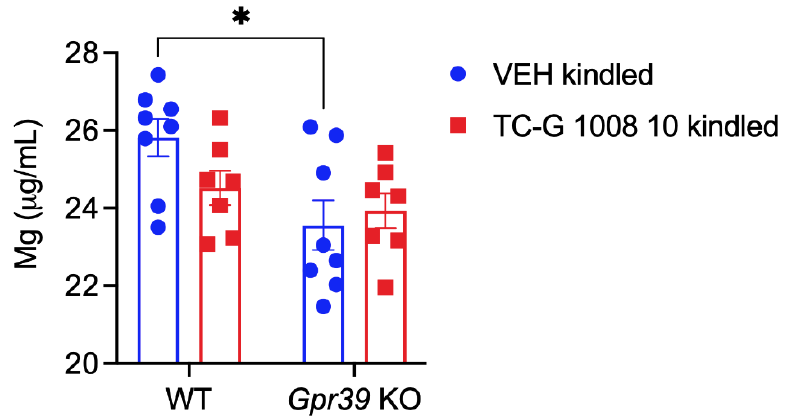
Figure 4. The effects of the PTZ kindling model and chronic treatment with TC-G 1008 (10 mg/kg) in Gpr39 -KO or WT (C57BL/6/Tar × CBA/Tar) mice on total serum magnesium concentration. ICP-OES analysis was performed at 24 h after the completion of the model. Data are expressed as means ± SEM. Data were analyzed by two-way ANOVA and Tukey’s multiple comparison test. Statistical details: genotype effect [F(1,26) = 7.526, p = 0.0109]; drug effect [F(1,26) = 0.8014, p = 0.3789]; genotype × drug effect [F(1,26) = 2.584, p = 0.1200] (by two-way ANOVA).* p < 0.05 (by Tukey’s multiple comparison test).